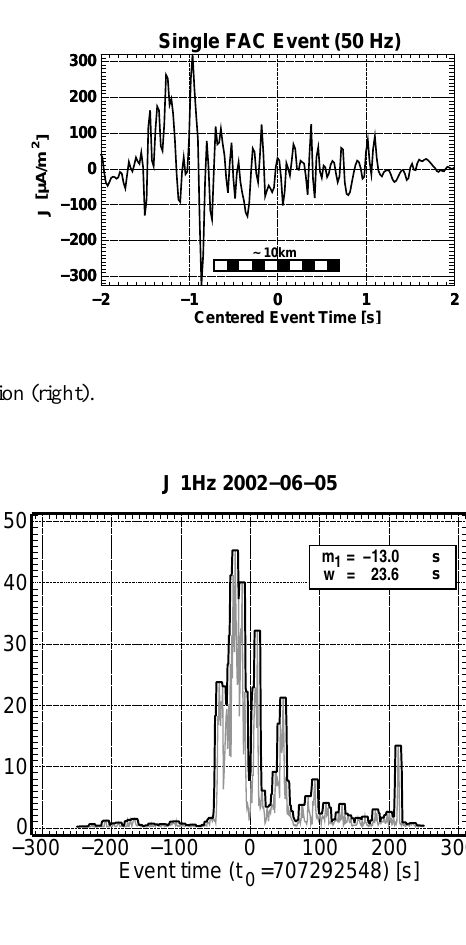
Fig. 4. Example of event at 1-Hz resolution, together with moments for characterisation of a KSFAC